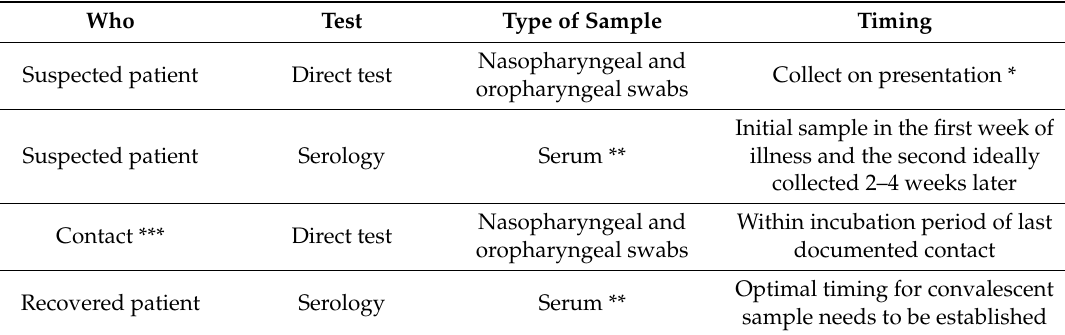
Table 1. Who what, and when to test for COVID-19 diagnosis / screening. From “Laboratory testing for coronavirus disease 2019 (COVID-19) in suspected human cases”, interim guidance, 2 March 2020, WHO, modified